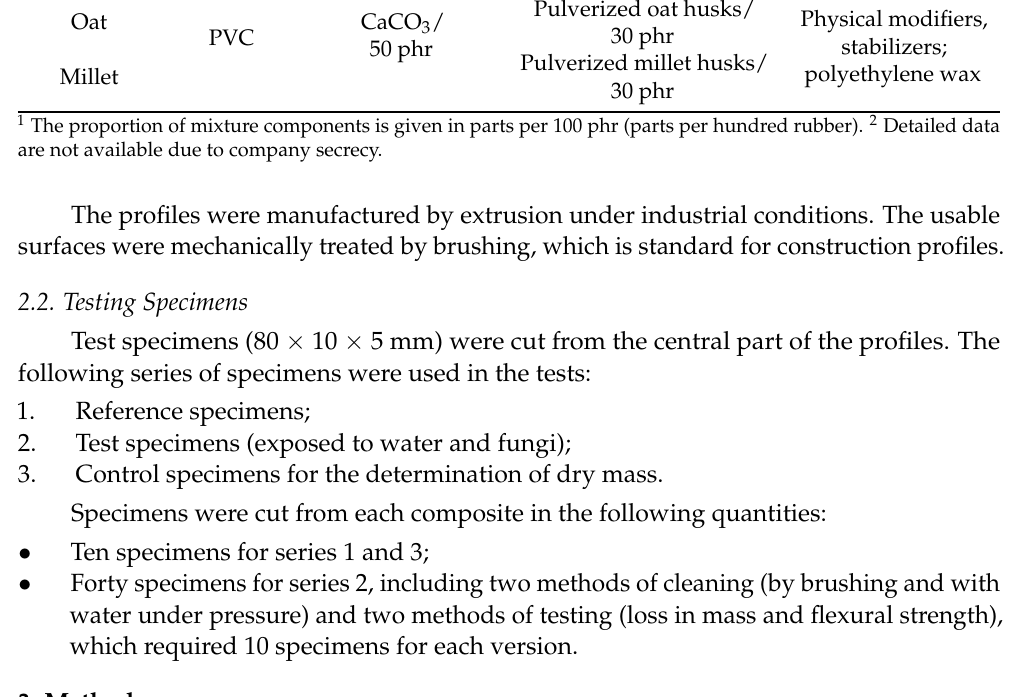
Other 2 Physical modifiers,